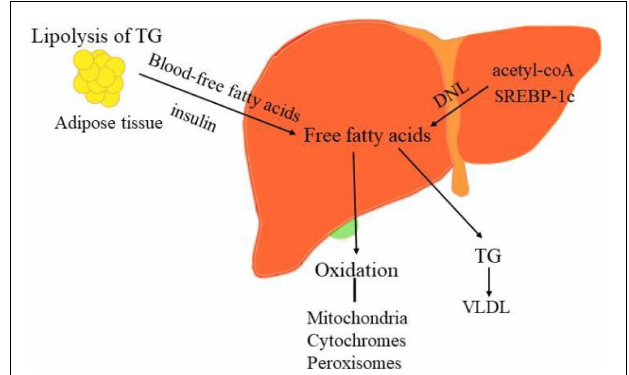
FIGURE 2 | The sources and disposal of hepatic free fatty acids. The key pathogenesis of NASH are hepatic free fatty acids. The liver acquires free fatty acids through DNL and lipolysis of triglyceride in adipocytes. Phosphorylation of JNKs in adipose tissue dramatically impacts insulin signaling, which contributes to excessive delivery of lipids to the liver and leads to NASH. Moreover, increased DNL also result in the elevated liver lipid content in NAFLD. DNL can be pharmacologically inhibited by targeting its synthetic enzymes acetyl-CoA, SREBP-1c, and ChREBP. Conversely, the disposal of fatty acids including oxidation in the mitochondria, cytochromes, and peroxisomes and formation of triglyceride